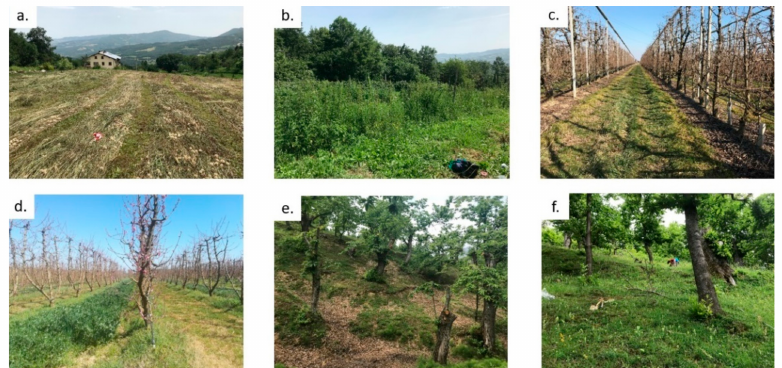
Figure 2. Representative images of the main land covers/uses typologies: ( a ) uncultivated grassland (HEL1), ( b ) raspberries (HEL3), ( c ) grassed orchards (pear, 18 yrs; ZAN1), ( d ) green manure (on the left) and grassed (on the right) orchards (peach, 10 yrs; BIO2 and BIO1, respectively), ( e ) chestnuts (MAR2), and ( f ) chestnuts (PIC4). The site codes are reported within the brackets (see Table